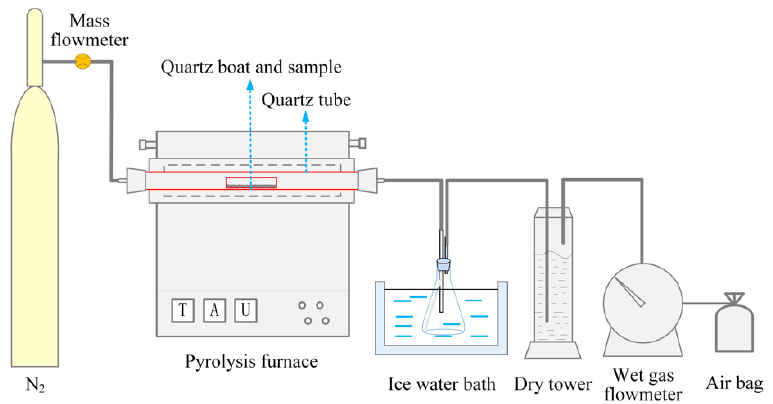
Figure 3. Schematic diagram of tube furnace pyrolysis device.